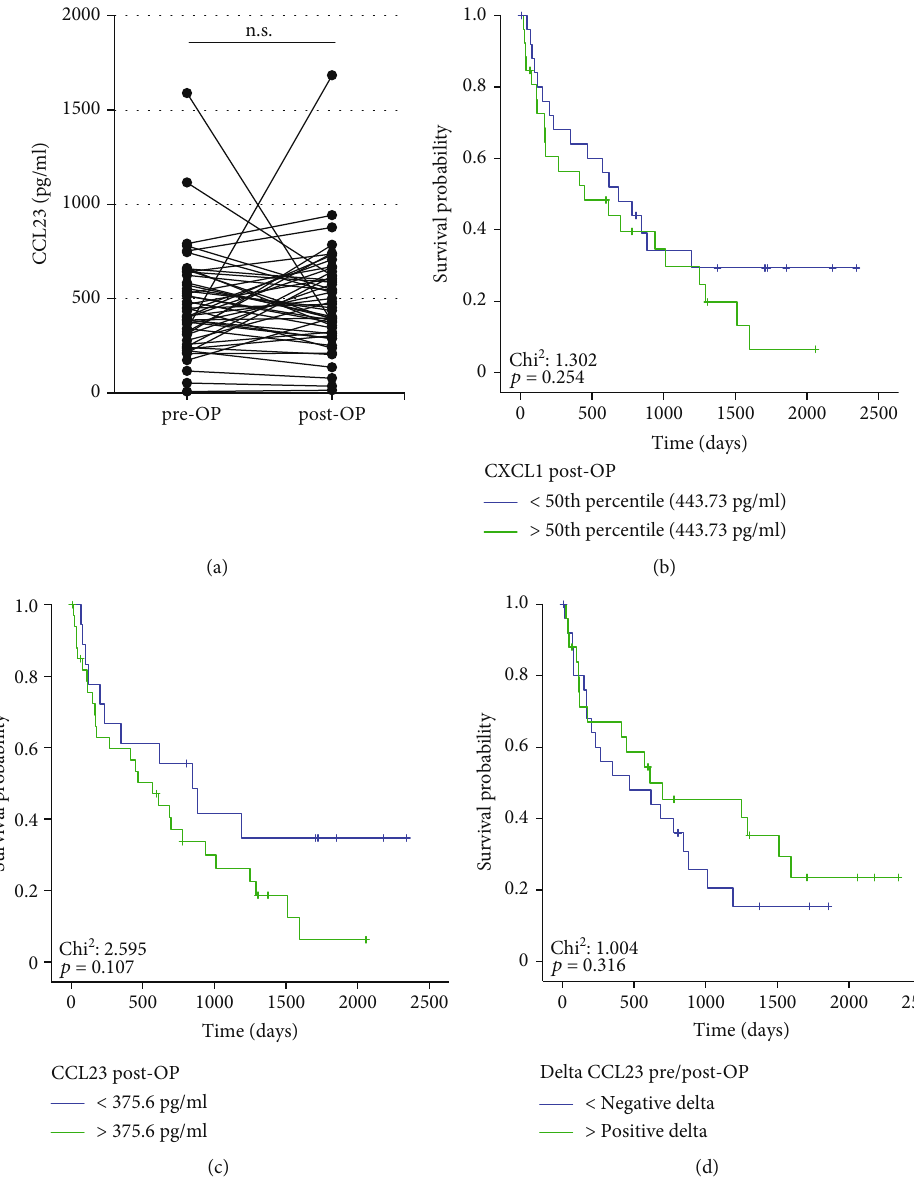
Figure 4: Postoperative CCL23 levels and patients ’ outcome. (a) Postoperative CCL23 levels do not signi fi cantly di ff er from the respective preoperative serum levels. (b, c) Neither the median nor an optimal prognostic cut-o ff value for postoperative CCL23 serum levels is able to identify BTC patients with a favorable or unfavorable postoperative outcome. (d) Individual changes of CCL23 levels before and after tumor resection (positive or negative delta) are unable to predict outcome of BTC